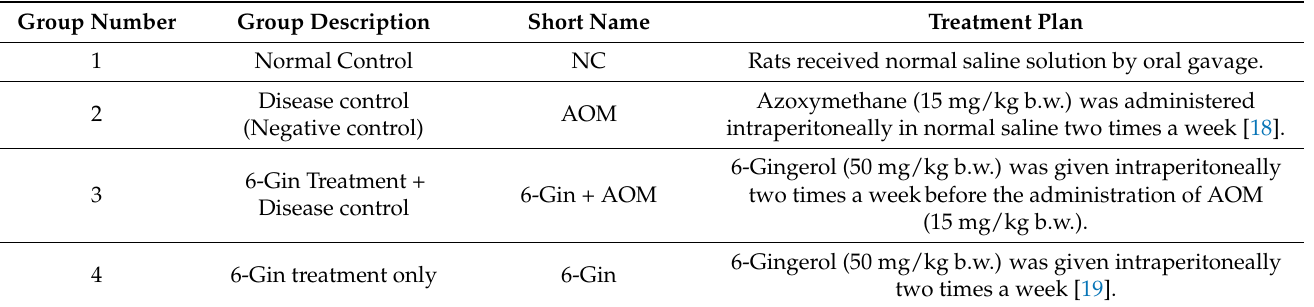
Table 1. Animal grouping and treatment